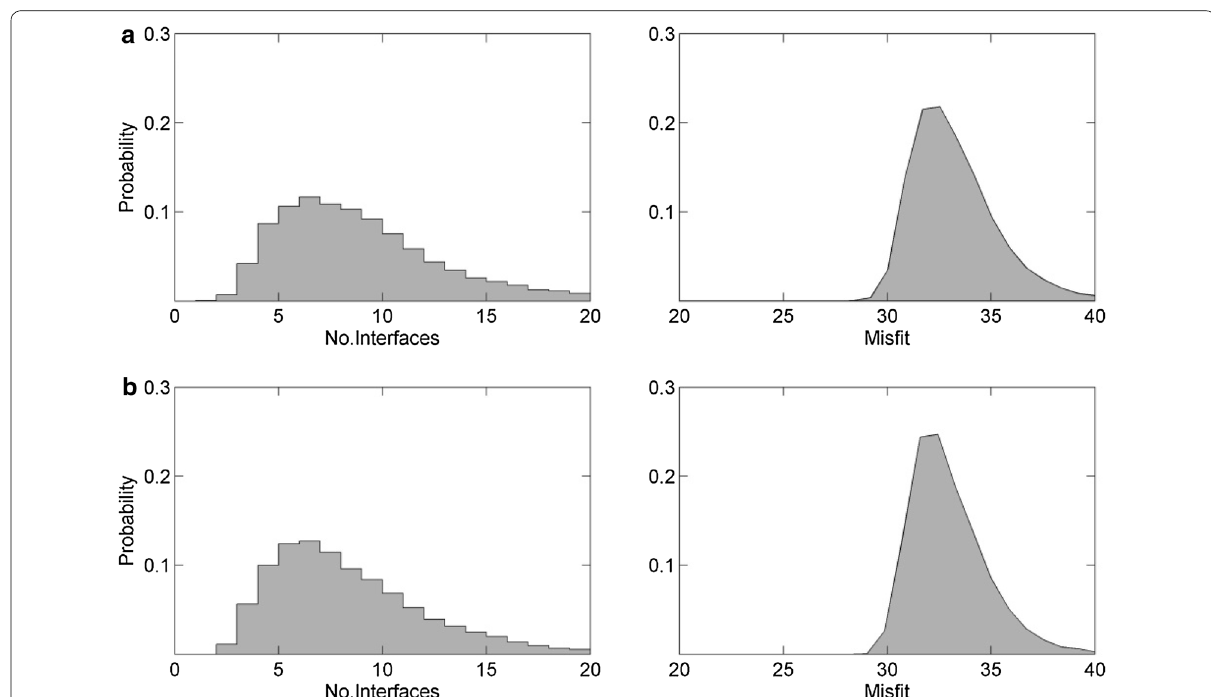
Fig. 9 1D marginal distributions for the number of interfaces k and data misfit for the inversions ( a ) with and ( b ) without considering error